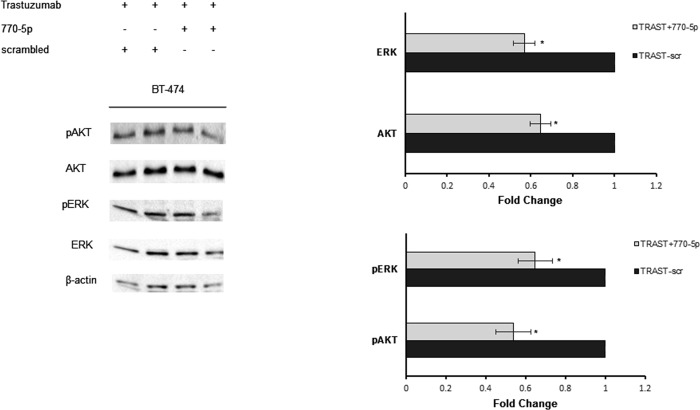
Trastuzumab treatment together with miR-770-5p modulates AKT and ERK expression level.miR-770-5p mimic was transfected to BT-474 cells and; total and phoshorylated AKT and ERK protein levels were analyzed by Western blot 72 h after transfection. Combination of trastuzumab with miR-770-5p mostly affected pERK and pAKT levels in BT-474 cells (n = 3, *p<0.05).